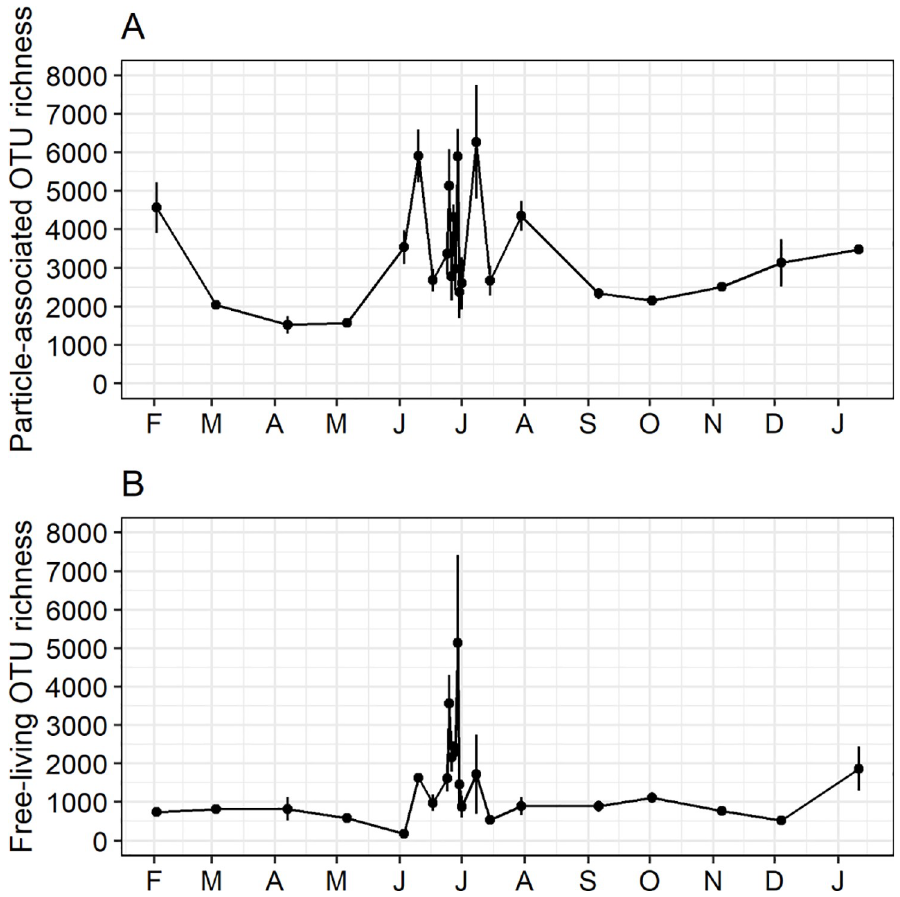
Fig 3. Temporal patterns in bacterioplankton alpha diversity measured using richness of OTUs. Differences in richness of OTUs in (A) particle-associated and (B) free-living bacterioplankton assemblages collected on 23 dates from February 2013 to January